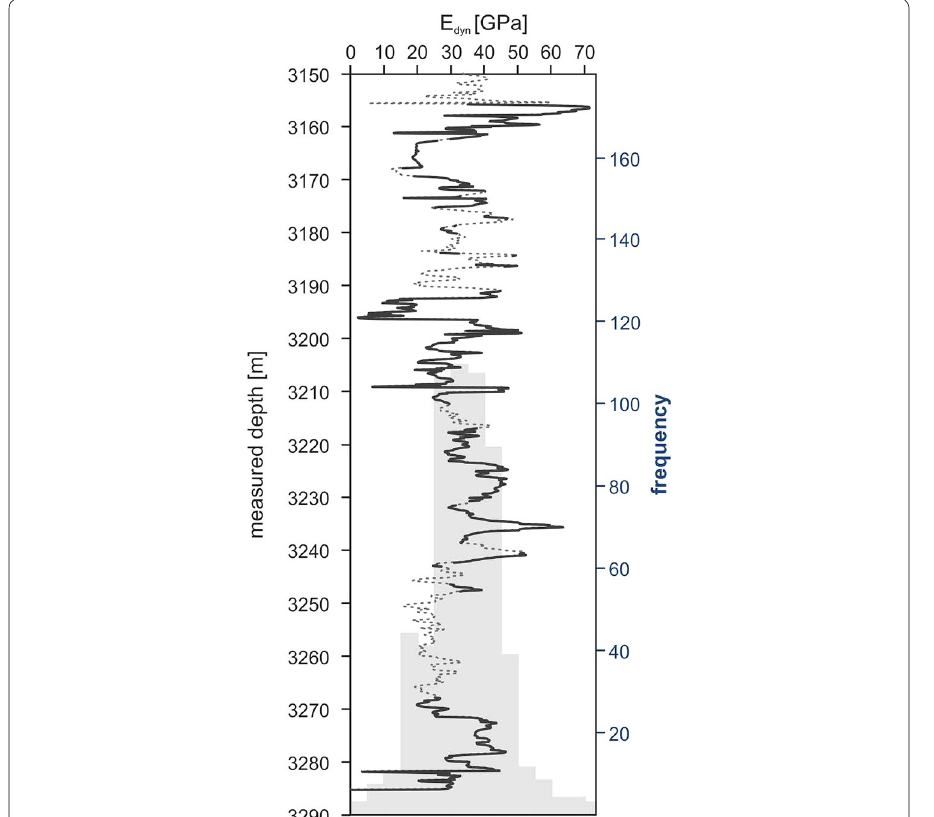
Fig. 12 Vertical variation of Young’s modulus with histogram. The grey dotted lines show data rejected due to bad hole conditions. The calculation is based on density and compressional ( v p ) and shear ( v s ) wave veloci‑ ties, as shown in Fig. 11a,